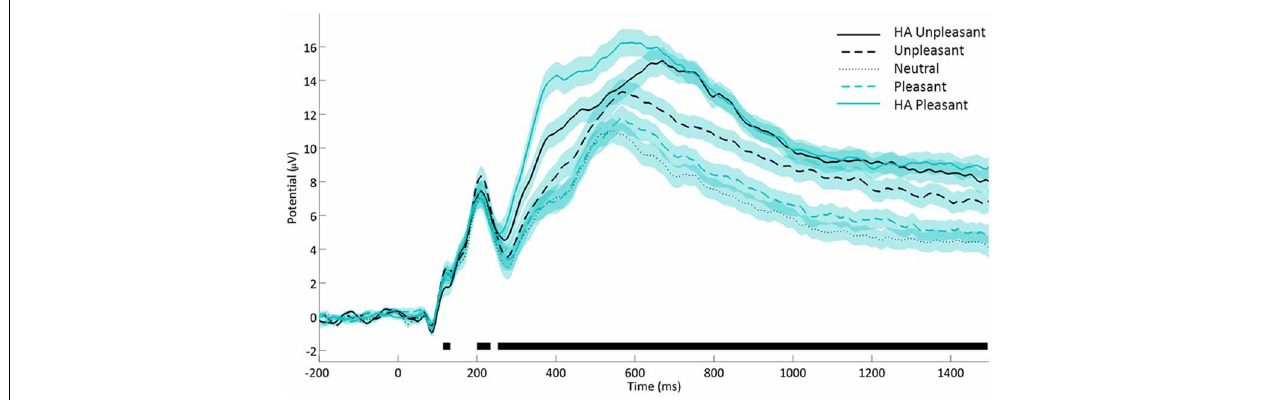
FIGURE 2 | Affective modulation of the late positive potential. Notes. Average voltage from CP1/CP2, P3/P4, PO3/PO4, and Pz. Shaded areas denote standard errors. Black lines denote time points with significant affective category main effect (ANOVA, false discovery rate corrected p < 0 . 05).